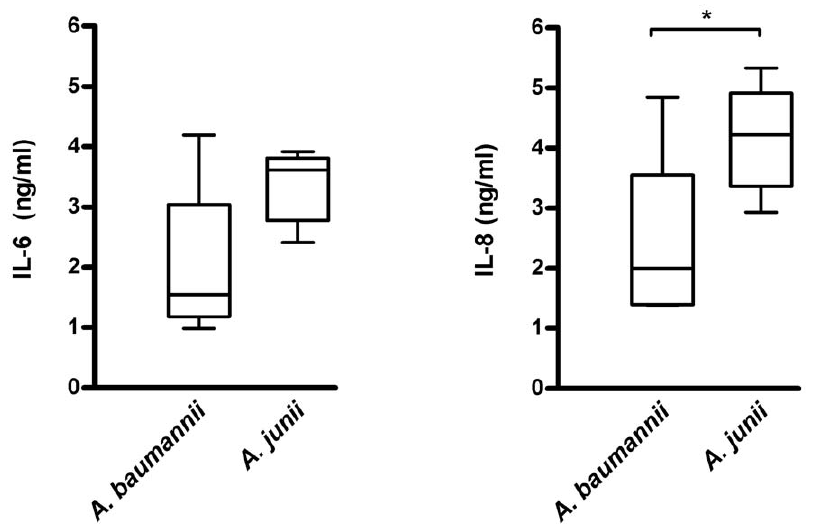
Figure 2. Cytokine production by human airway epithelial cells in response to Acinetobacter . Boxplots showing IL-6 and IL-8 production in ng/ml by H 292 airway epithelial cells 24 h after stimulation with strains of A. baumannii (n=6) and A. junii (n=6). Boxes represent medians and second and third interquartiles, whiskers represent range of 6 strains. *significant (p # 0.05) difference between A. baumannii and A. junii .